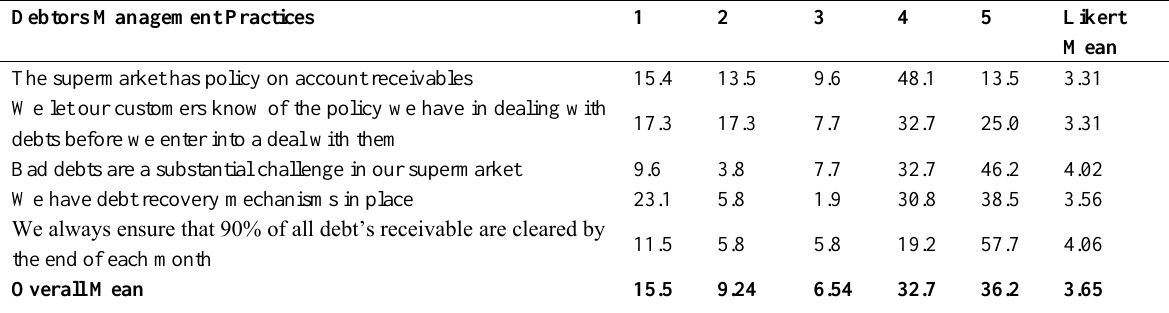
Table 4: Analysis of Debtors Management Practices and Operational